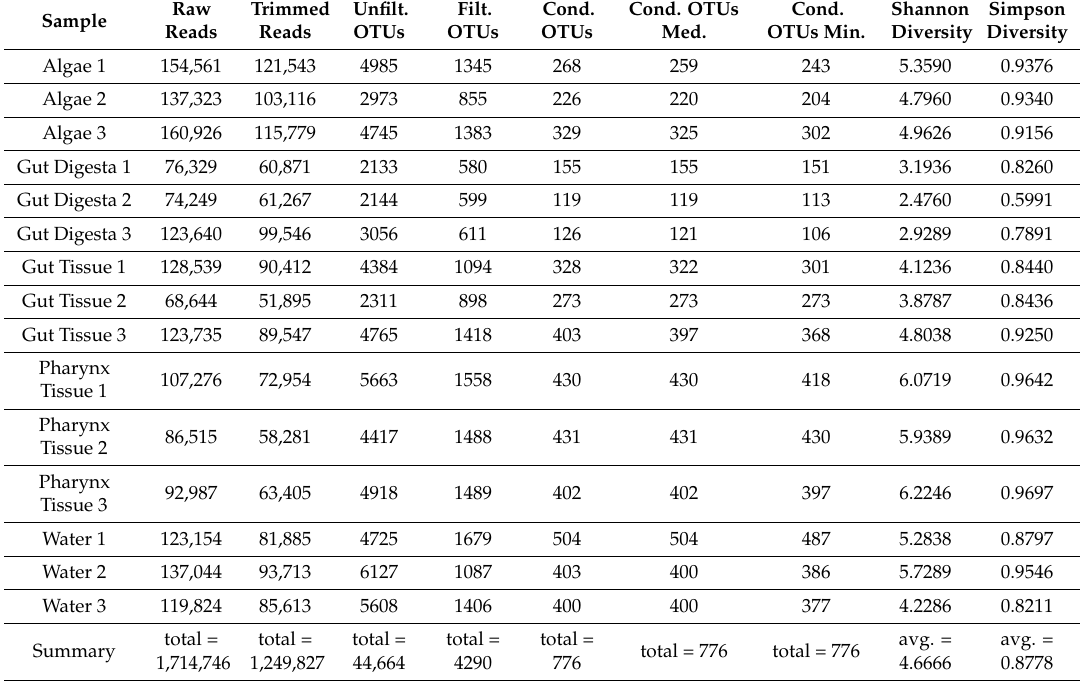
Table 1. Sequence reads, operational taxonomic unit (OTU) count, and alpha diversity of each sample of the study. The table shows the sequence read count (1) before and (2) after quality checking and filtering based on low quality reads using FASTX Toolkit, the (3) unique unfiltered (Unfilt.) OTU observances following chimera removal, (4) the filtered (Filt.) OTUs after removal of rare OTUs (<0.0005% abundant in all samples), (5) the resultant condensed (Cond.) OTU count following the merging of redundant taxonomic information through Phylogenetic Tools for Analysis of Species-level Taxa (PhyloToAST) (v1.4.0), (6) the OTU count following subsampling to the median (Med.) value (77,806), and (7) the minimum (Min.) value (49,641). Also shown are the (8) Shannon and (9) Simpson diversity indices corresponding to each sample determined using the condensed OTU table